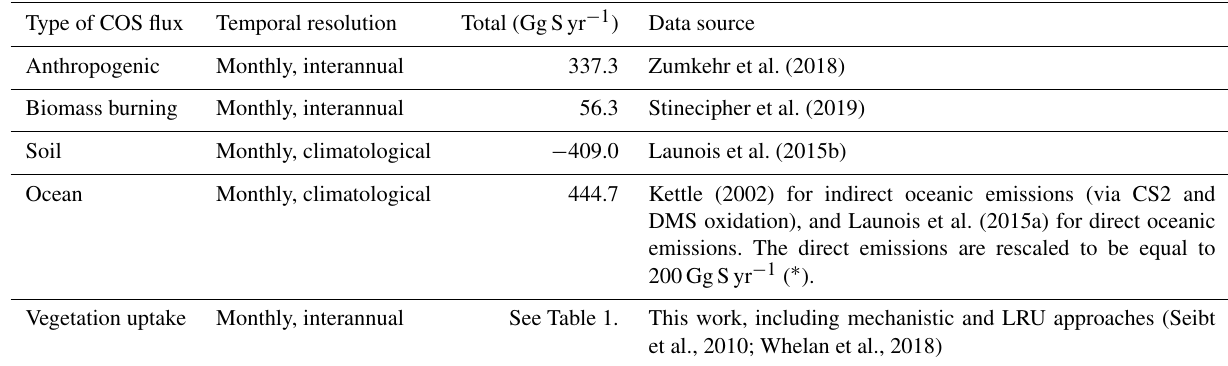
Table 2. Prescribed COS surface fluxes used as model input. Mean magnitudes of different types of fluxes are given for the period 2000–2009.